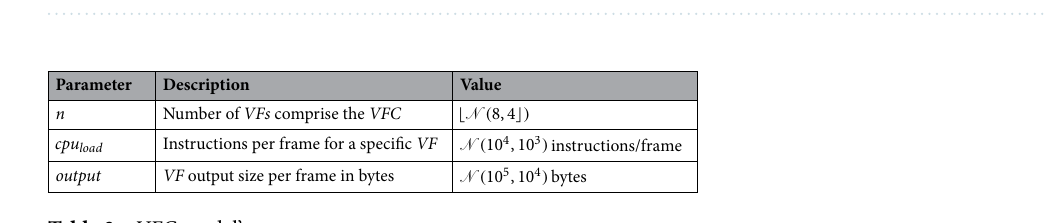
Table 2. Edge environment model’s parameters.